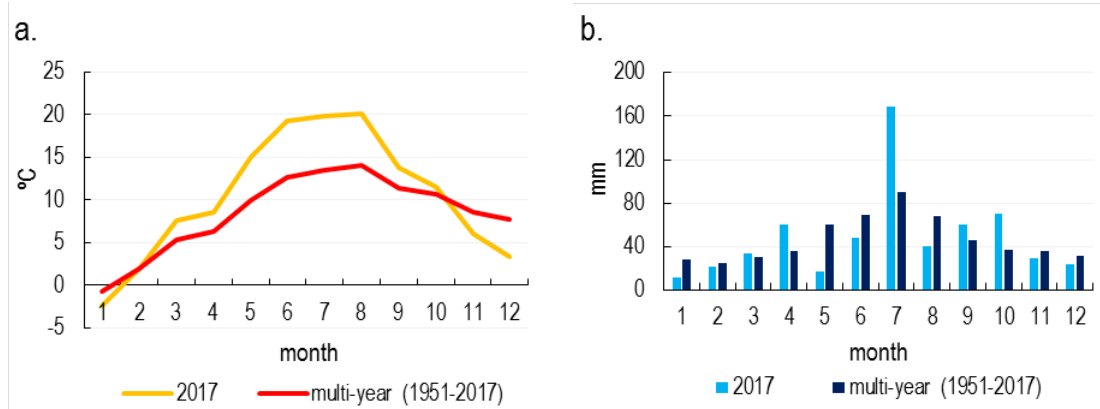
Figure 2. The median monthly air temperature ( a ) and monthly total precipitation ( b ) in Wrocław in 2017 and the multiannual period 1951–2017 (based on [49]).